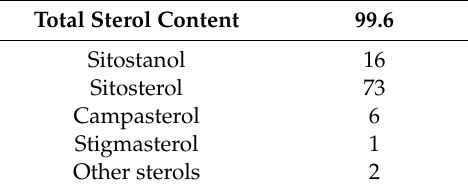
Table 4. Wood sterols composition (%).